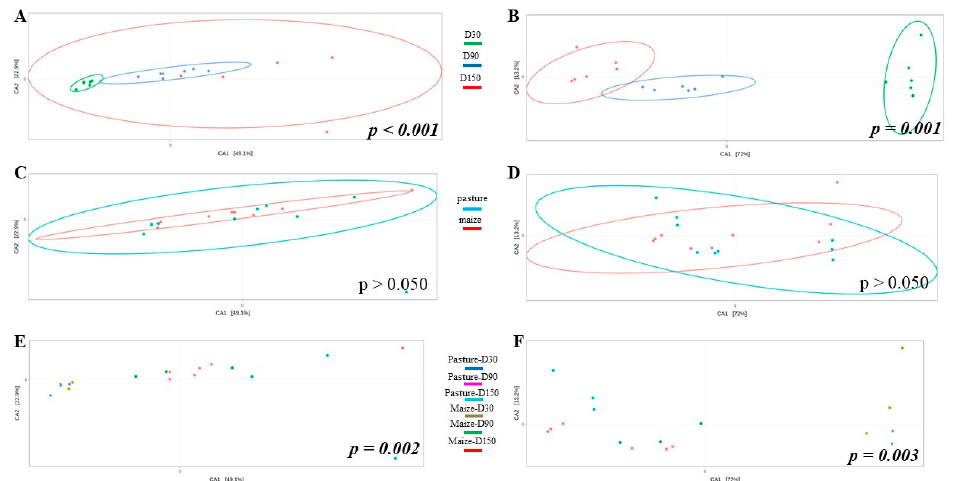
Figure 3. CCA built from Bray-Curtis dissimilarity matrix and comparing bacterial ( A , C , E ) and fun- gal ( B , D , F ) community structure of raw milk cheese rinds as function of ripening time ( A , B ), cream origin ( C , D ) and interaction between both factors ( E , F ); p -values written in italic bold are